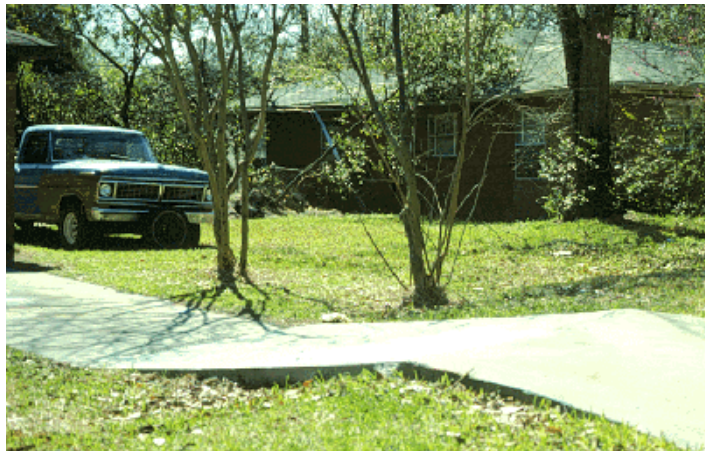
Figure 4. Land subsidence in the area of Pasadena [69] .